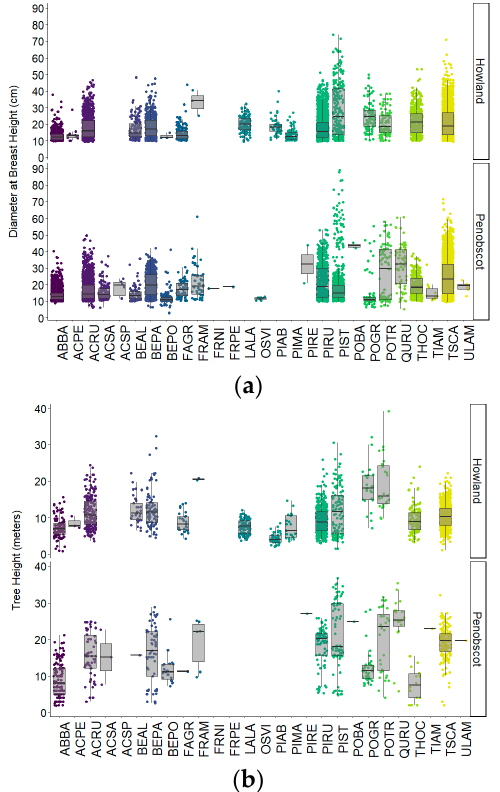
Figure 2. Plots of individual tree diameters at breast height by species. Summary of diameter at breast height data ( a ) and individual tree height data ( b ) for on trees in experimental plots in Howland Experimental Forest and Penobscot Experimental Forest. Dots represent data on individual trees; overlaid box-and-whisker plots summarize distribution of values by species for each forest.